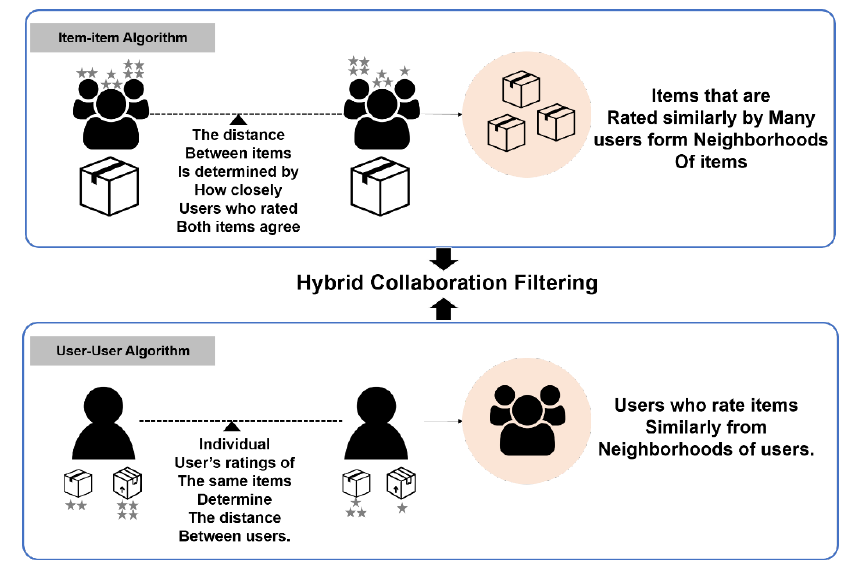
Figure 3. Process of hybrid collaboration filtering.